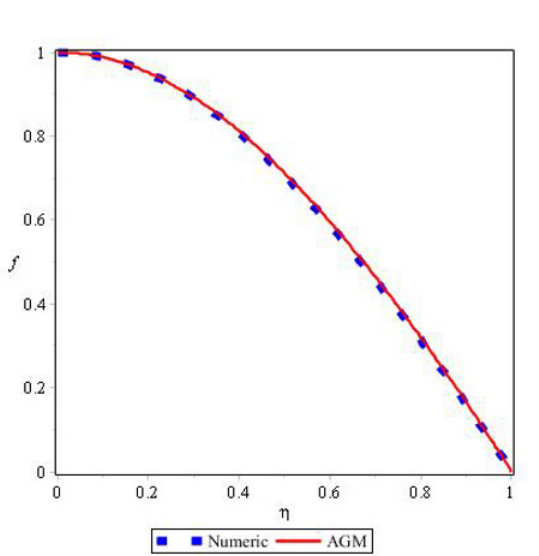
Figure 15. Comparison between the obtained solutions for f AGM and Numerical Method ( A ∗ = 1 , Ha = 0 , Re = 50 , α = 2 ◦ , φ = 0 ).